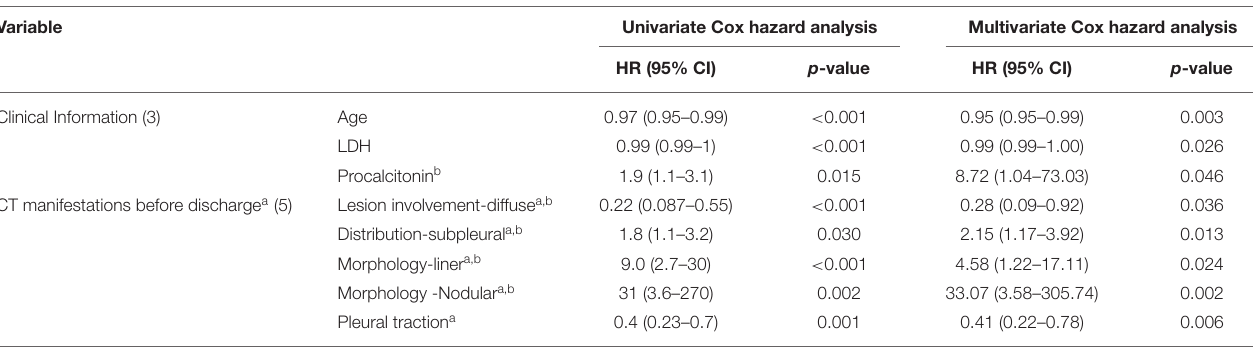
TABLE 6 | Results of univariate and multivariate Cox proportional hazard regression